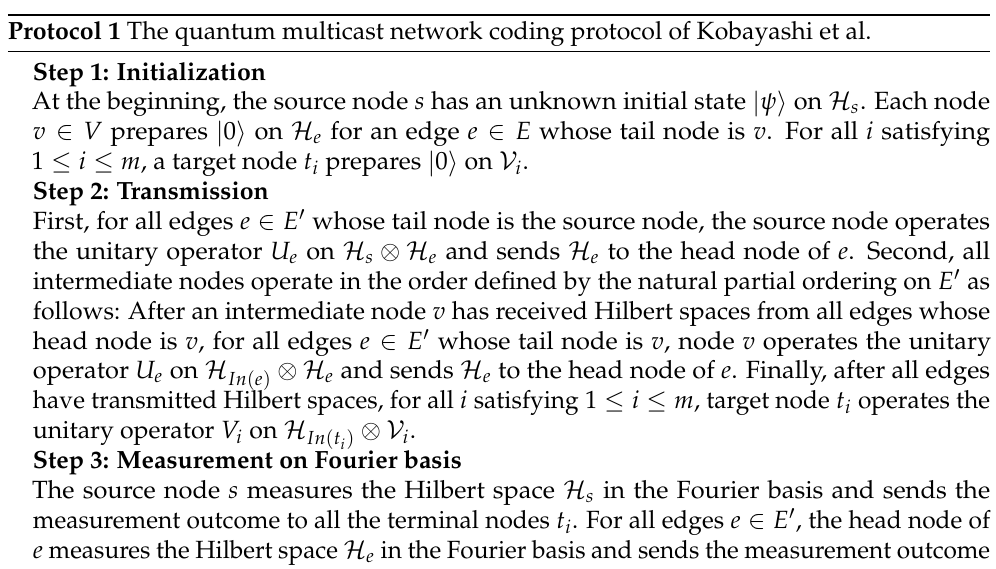
Protocol 1 The quantum multicast network coding protocol of Kobayashi et